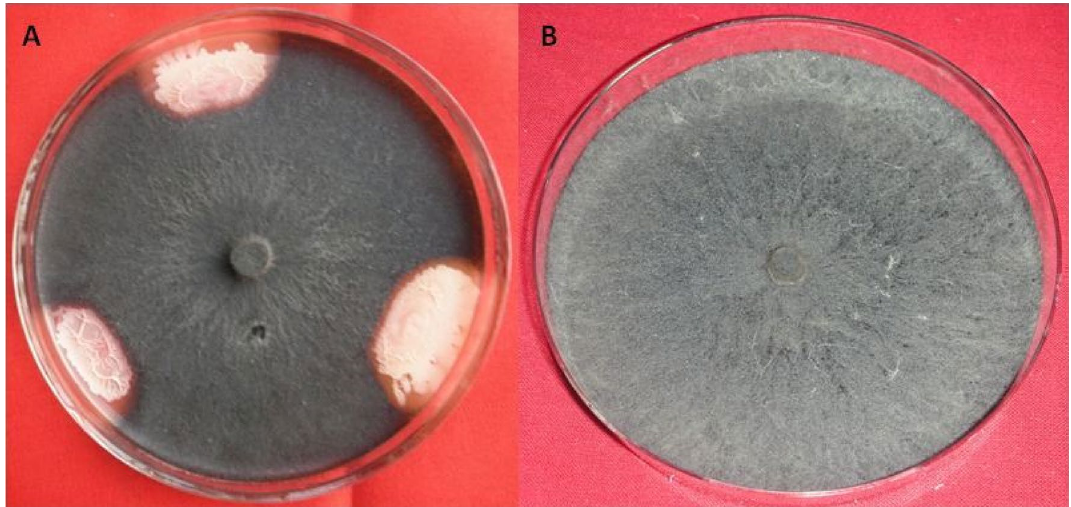
Figure 5. Antagonistic activities of Bacillus cereus LPR2 against Macrophomina phaseolina, Test plate ( A ) and Positive Control plate ( B ). Isolates Seed Germination (%) Root length (cm) Shoot length (cm)